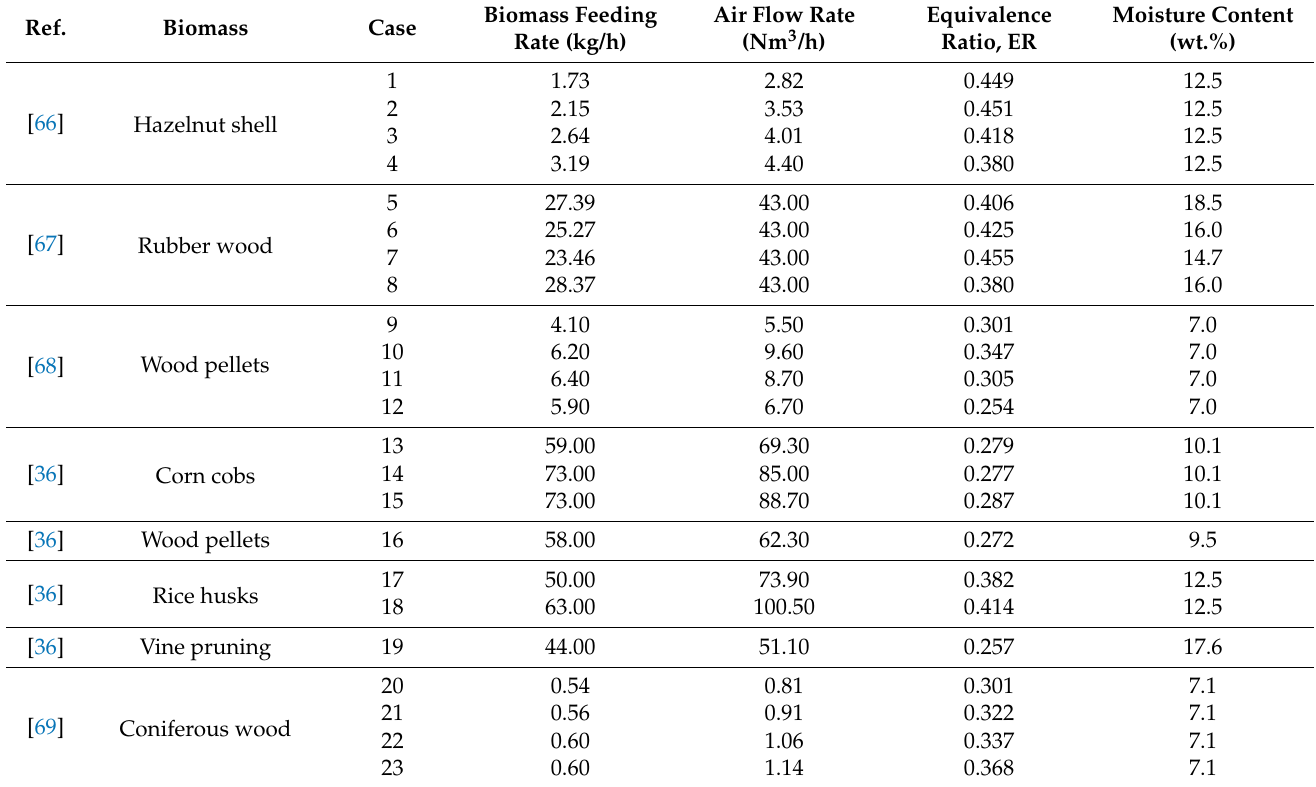
Table 3. Gasifier operating conditions from the experimental tests used for the validation of models.